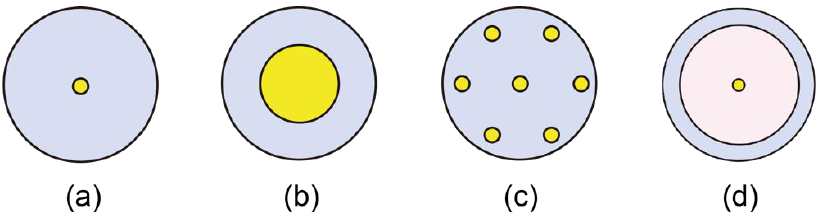
Figure 1. Cross sections of various types of optical fibers for PWoF [8]. ( a ) Single-mode fibers (SMFs), ( b ) Multimode fibers (MMFs), ( c ) Multicore fibers (MCFs), and ( d ) Double-clad fibers (DCFs).